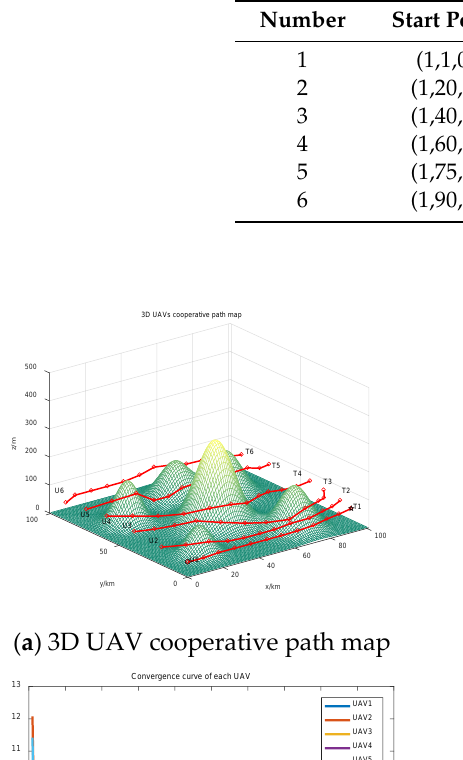
( a ) 3D UAV cooperative path map ( b ) contour map of cooperative path